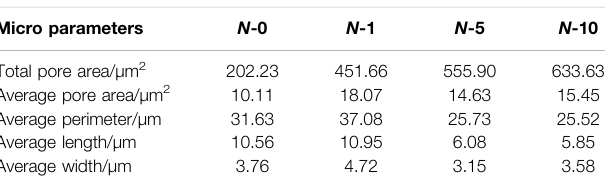
TABLE 4 | Actual pore size after conversion. Micro parameters